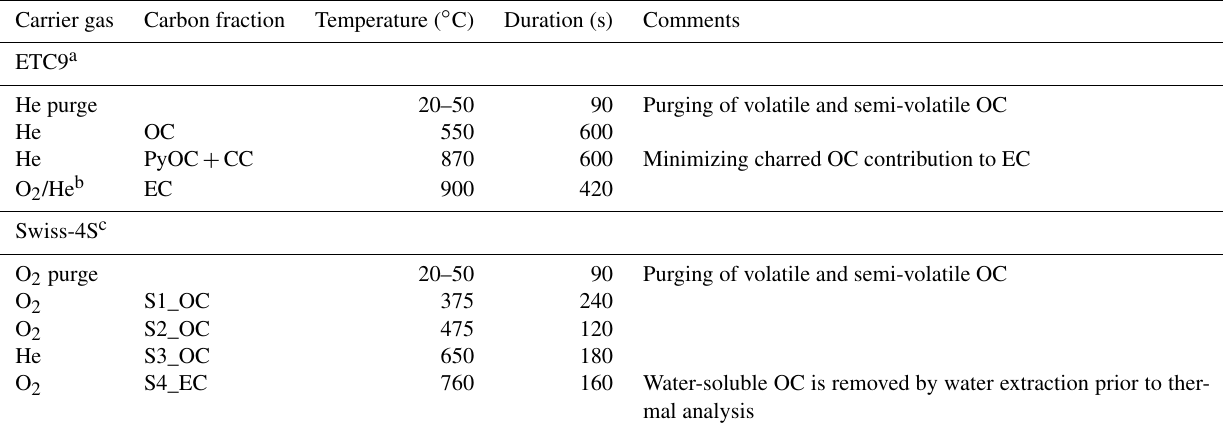
Table 3. Comparison of the OC and EC ECT9 and Swiss-4S isolation protocols. Carrier gas Carbon fraction